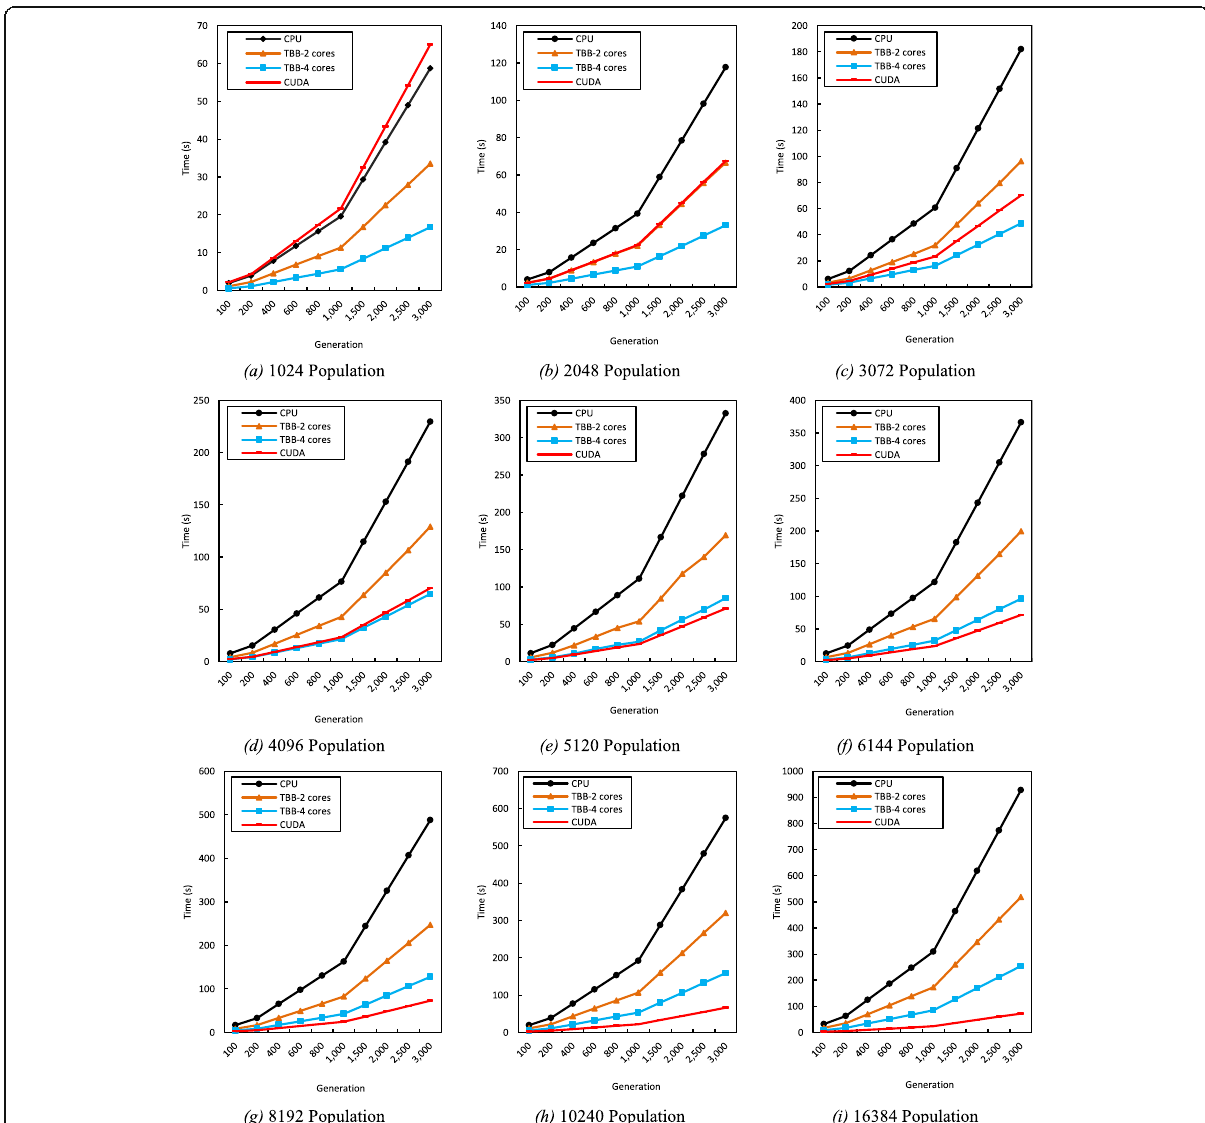
Fig. 6 The running time of the algorithm over different numbers of generations and different sizes of population. Each subplot is labeled with the corresponding population